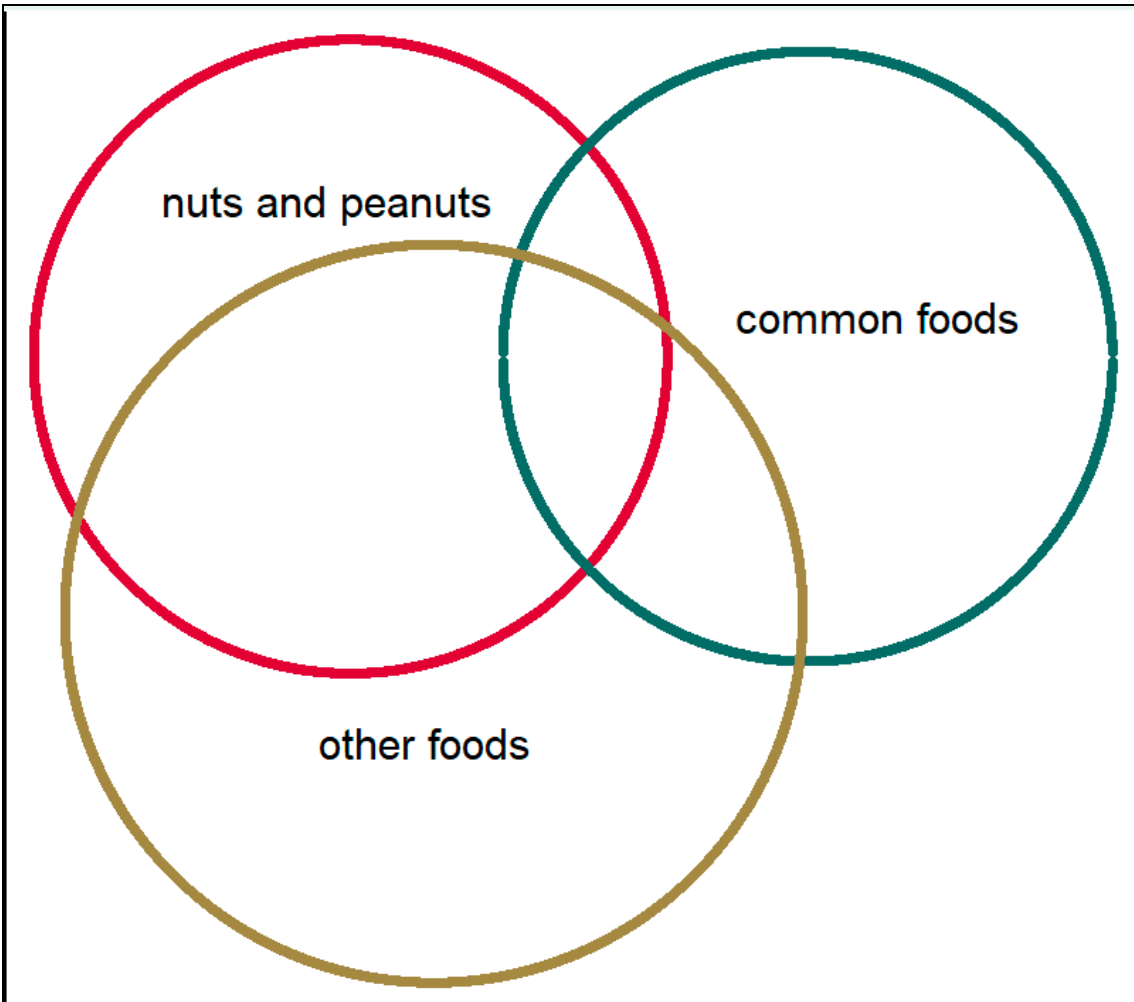
Figure 1. The distribution of symptoms of different food items among adolescents with food hypersensitivity. Common foods: milk, egg, fish and wheat. Nuts and peanuts: peanut, hazelnut, almond, walnut/pecan, cashew/pistachio, Brazil nuts. Other foods: Shellfish, soy, sesame seed, apple/pear, peach/nectarine/plum/cherry, kiwi, banana and raw carrot.